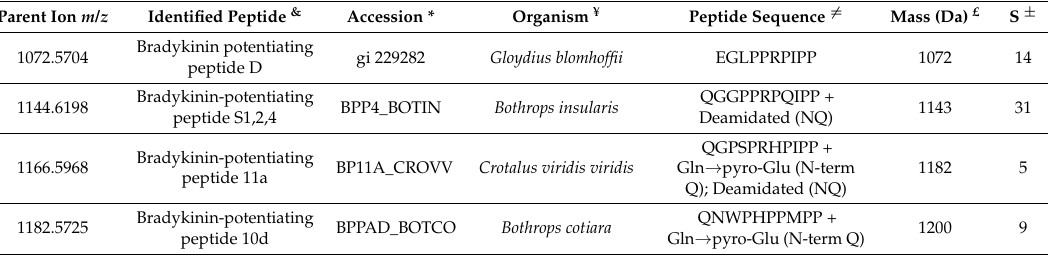
Table 2. Composition of the peptidome of V. berus berus